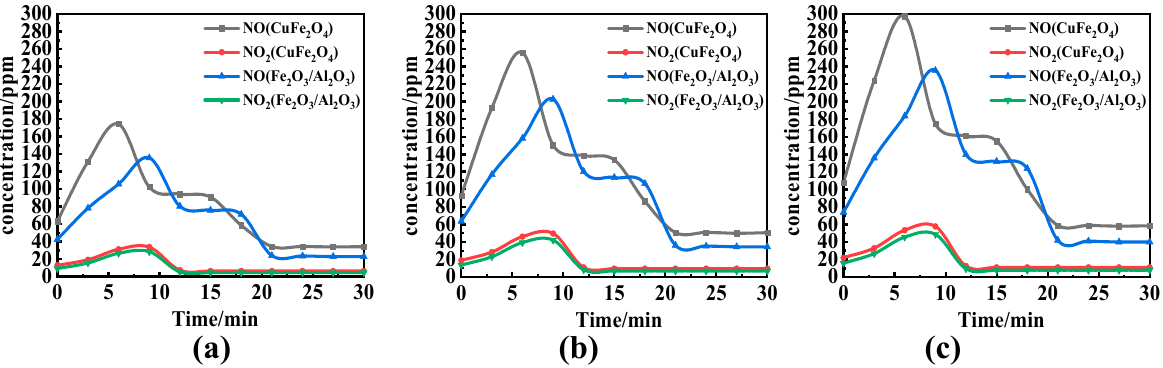
Figure 12. Trends of NO and NO 2 over time during reduction using iron-based oxygen carriers and CuFe 2 O 4 as OC in ( a ) 1st, ( b ) 5th and ( c ) 10th cyclic